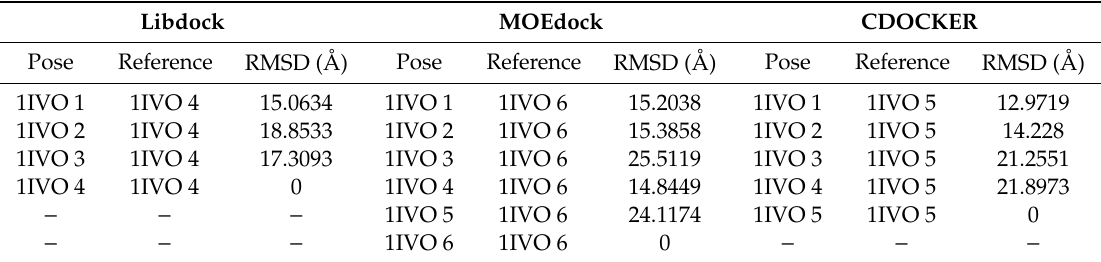
Table 2. Molecular docking between EGF and EGFR using the Libdock, MOEdock, and CDOCKER algorithms.